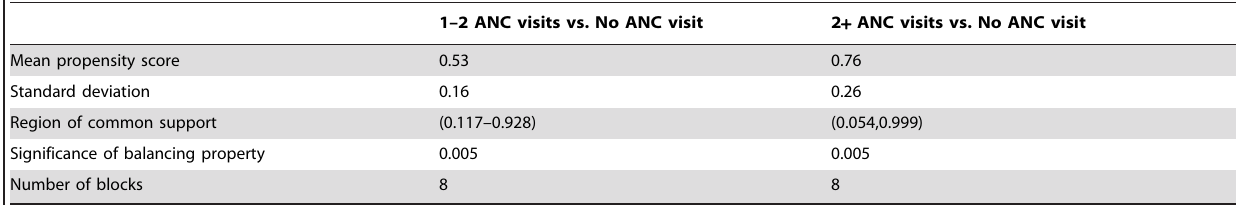
Table 2. Estimated propensity scores.